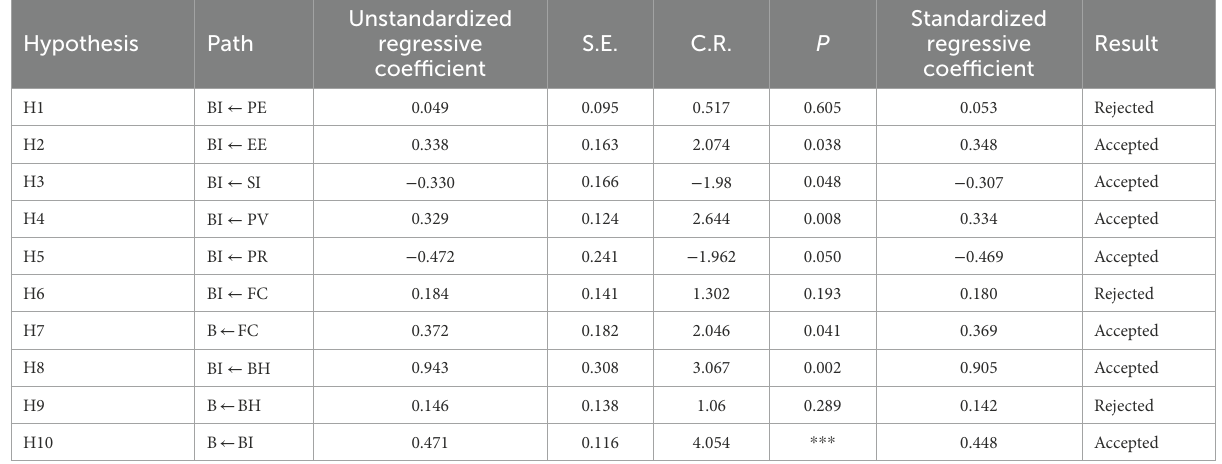
TABLE 4 Analysis of model